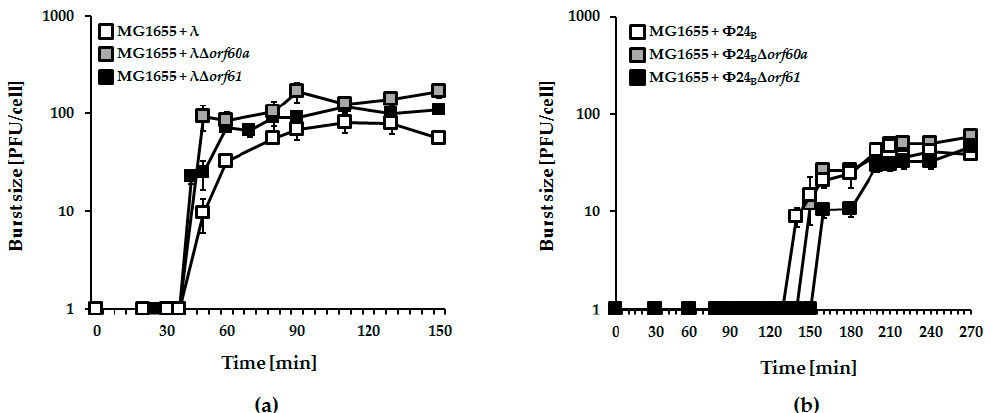
Figure 4. One-step growth experiments with λ (panel ( a ); white squares), Φ 24 B (panel ( b ); white squares), and recombinant phage mutants bearing deletions of orf60a (panels ( a ) and ( b ); grey squares) or orf61 (panels ( a , b ); black squares), infecting E. coli MG1655 host. Mean values from three independent experiments with error bars indicating S.D. are shown.